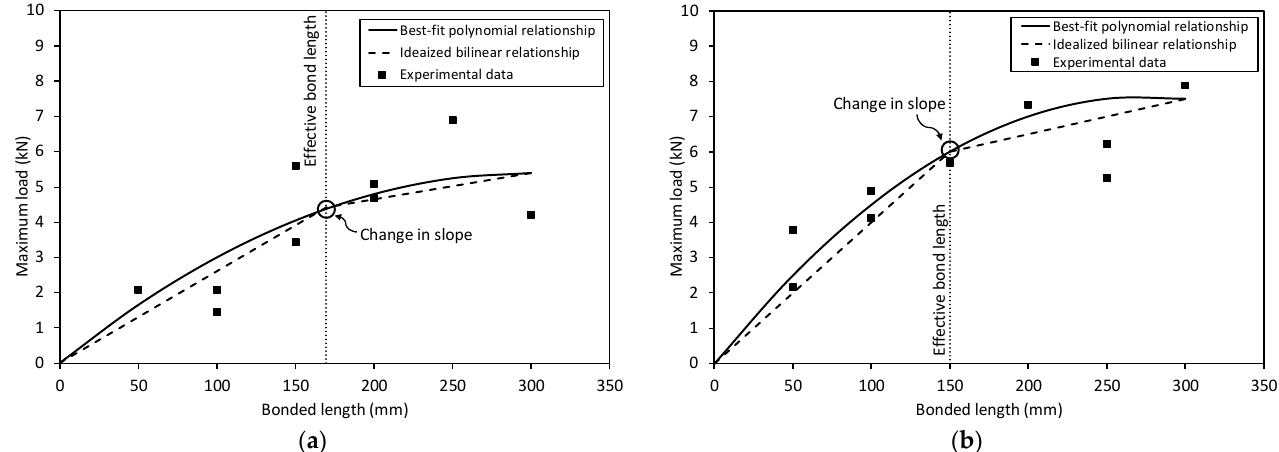
Figure 3. Maximum load-bond length relationship: ( a ) Cementitious-matrix specimens; ( b ) Geopolymeric-matrix specimens.